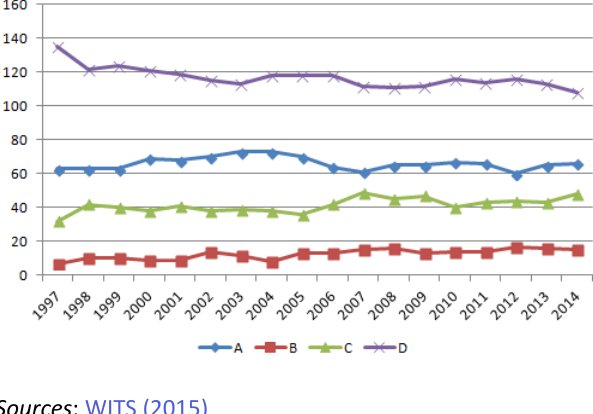
Figure 5: Trends in Number of Products Groups A, B, C and D of Singapore, 1997-2014 Thailand has positive trend for products A (in the past two years) and products C, neg - ative trend for products D, and flat curve for products B. Thailand shows increasing in compar - ative advantage and exports specialization.